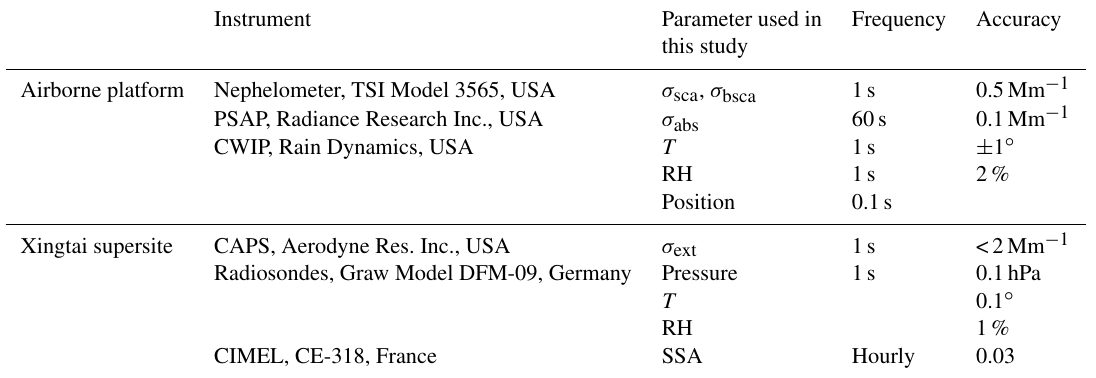
Table 2. Instruments used in this study. Instrument Parameter used in Frequency Accuracy this study Airborne platform Nephelometer, TSI Model 3565, USA σ sca , σ